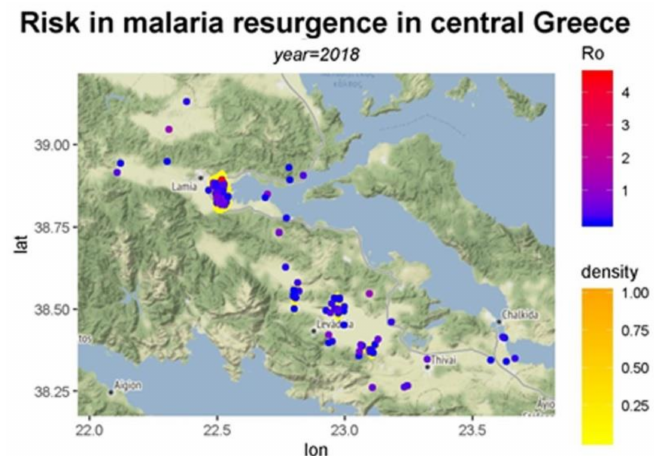
Figure A4. Heat-map of risk of malaria transmission (R 0 estimates).